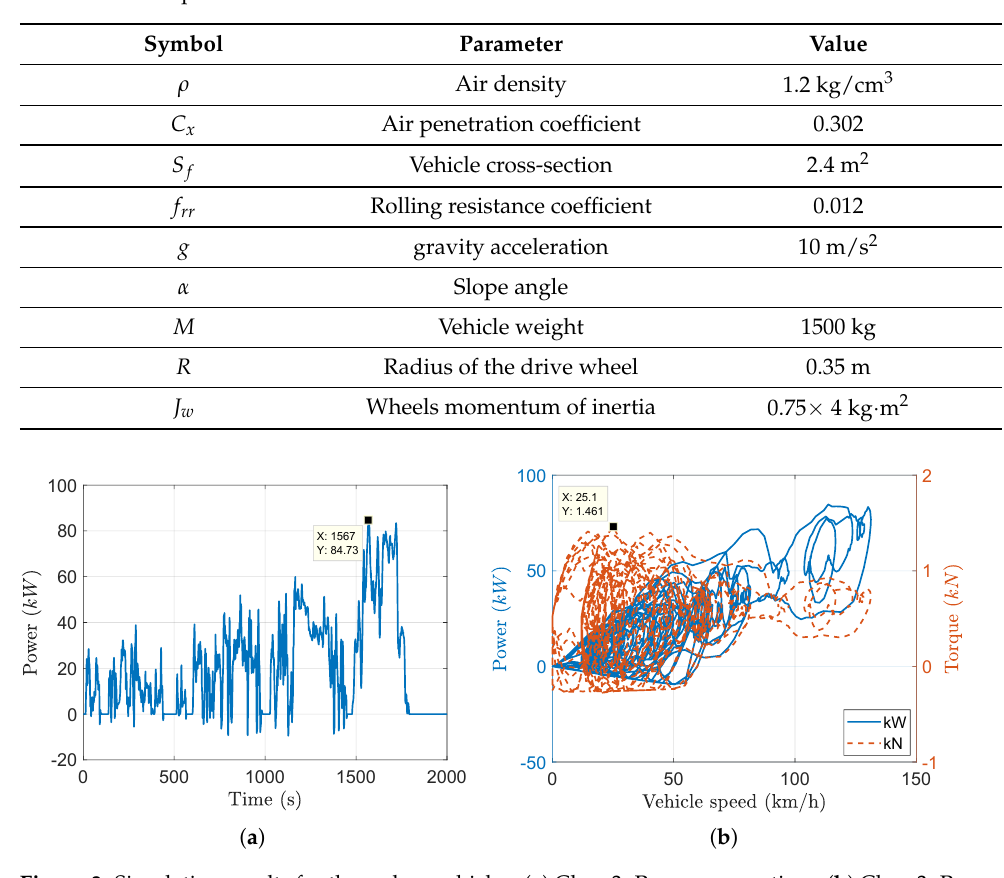
Figure 3. Simulation results for three class vehicles. ( a ) Class 3: Power versus time. ( b ) Class 3: Power versus vehicle speed.